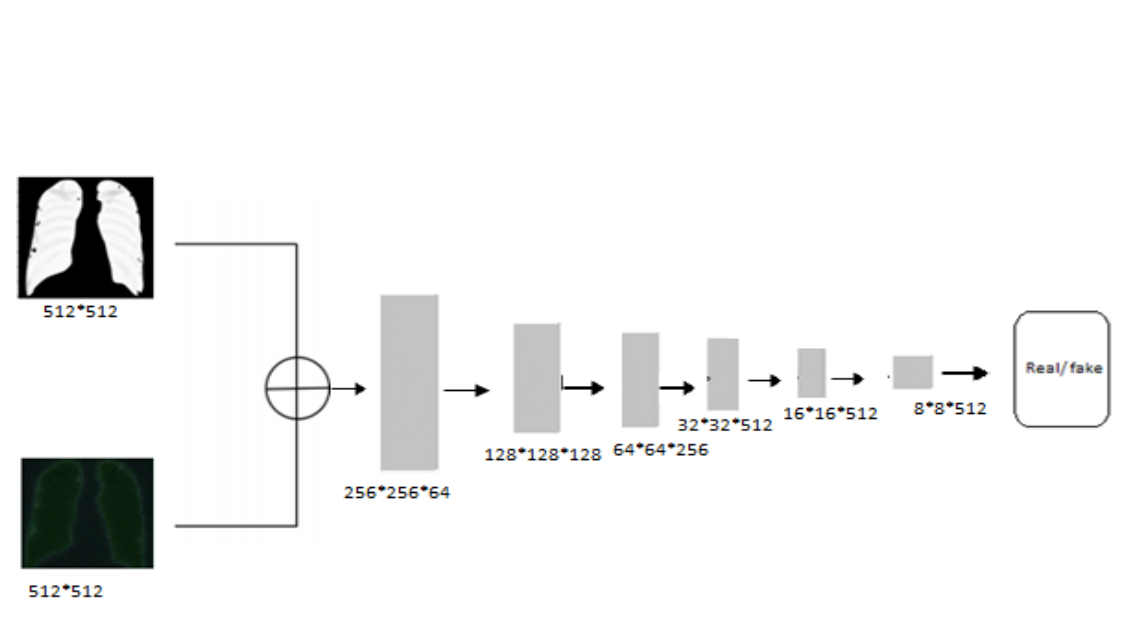
Figure 3. (cid:2)(cid:2)(cid:2) The discriminator in our work takes two images, mask real and mask generated by the generator, two sequences together that are categorized as real or fake. The model is optimized using binary cross-entropy. The network in this work consists of six layers, one of which is the input, four layers of the Relu convolution batch normalization model are hidden, and the last is a final output layer. For the used discriminators, the step size and kernel were fixed using the values 2 and 4 × 4,